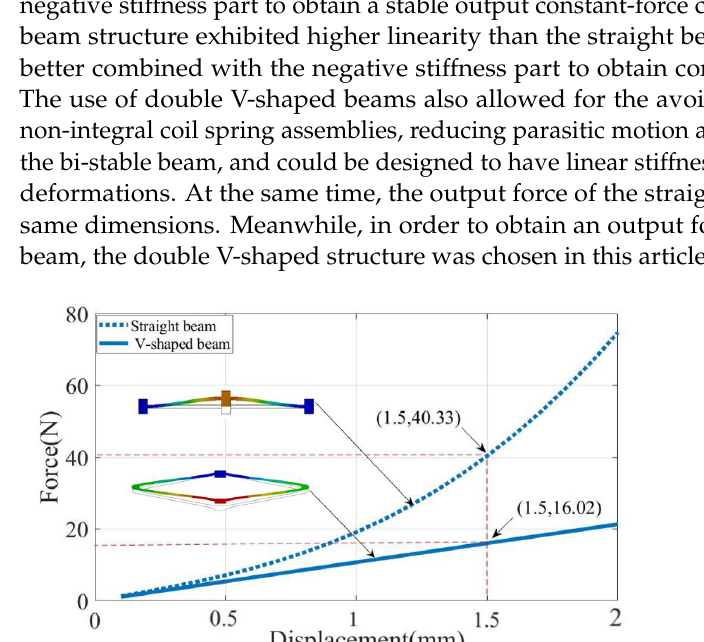
Figure 1. A schematic of the CFM: ( a ) axonometric view; ( b ) front view.